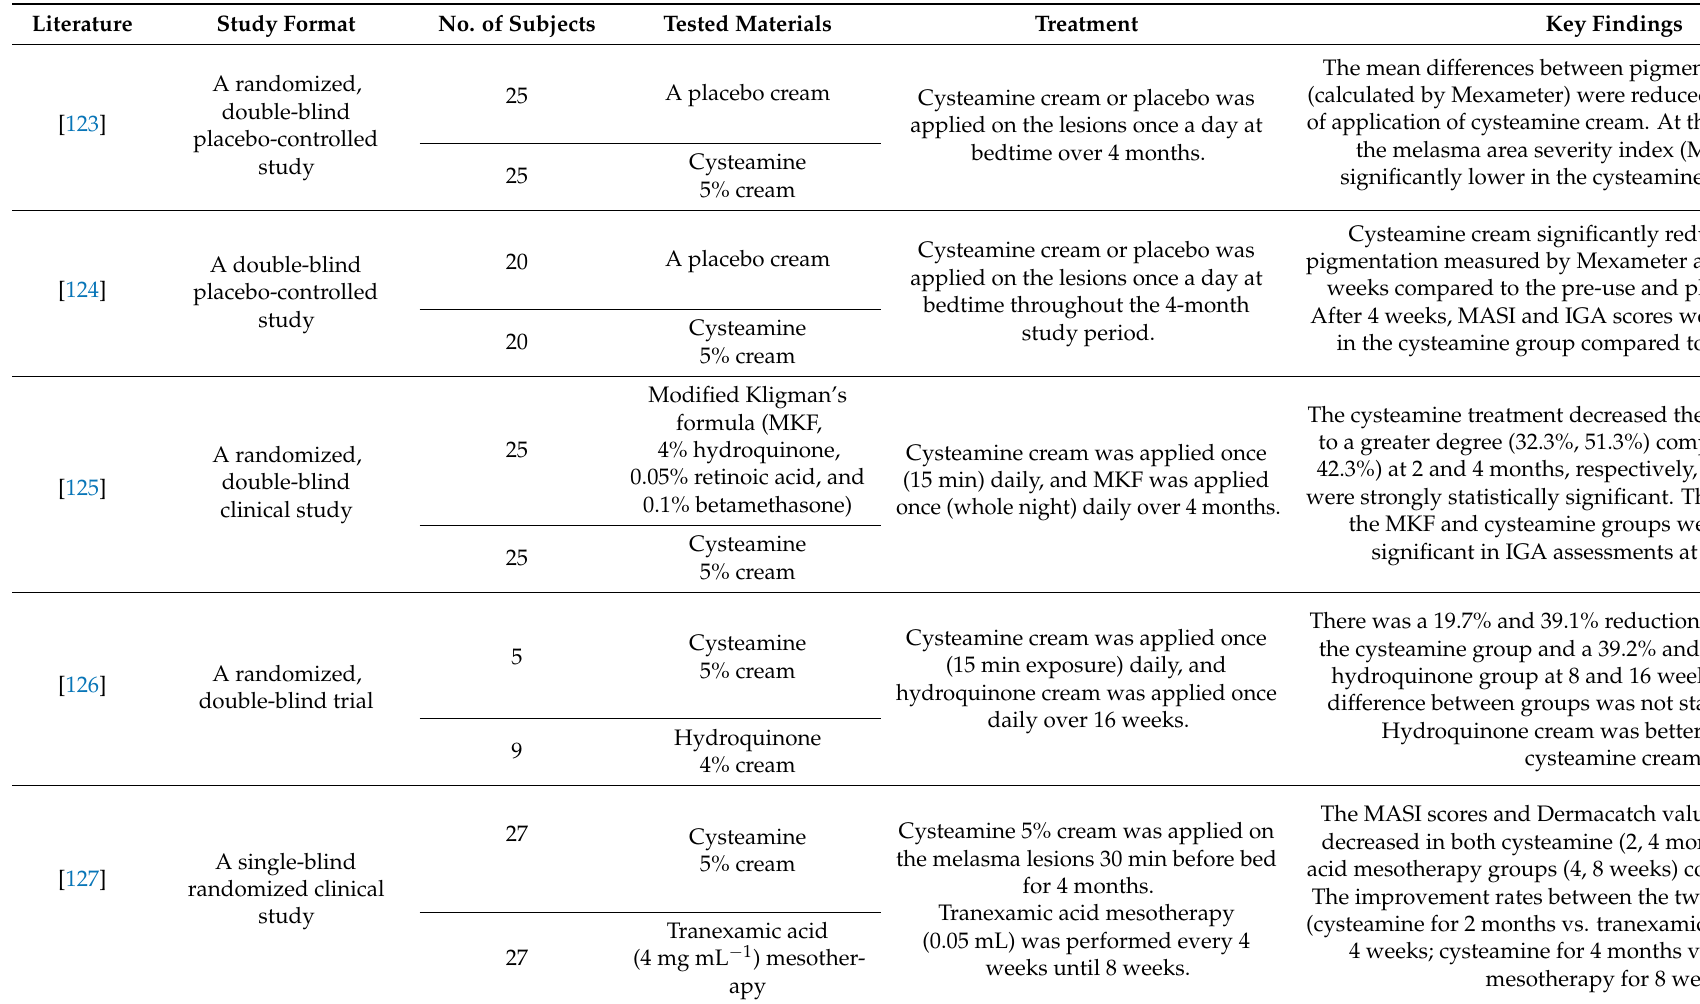
Table 2. Clinical trials on the skin lightening efficacy of